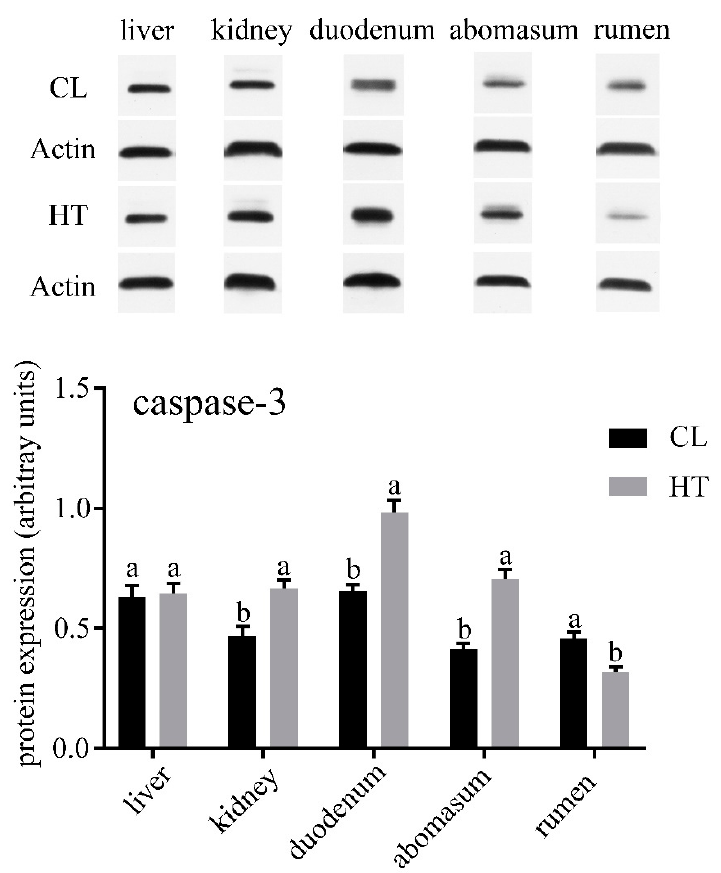
Figure 2. Effects of the THI on the caspase3 expression of the liver, kidney, duodenum, abomasum and rumen in the HT and CL calves. Treatment was as follows: (1) HT: Calves were fed from July 15 to August 19; (2) CL: Calves were fed from April 10 to May 15. Insets depict representative blots. Values represent means ± standard deviation. Response from statistical result, p < 0.05. β -Actin was used to normalize the expression of target proteins. The letters below the bar graph indicate different organs. Different letters above the bar indicate differences between different groups ( p < 0.05).